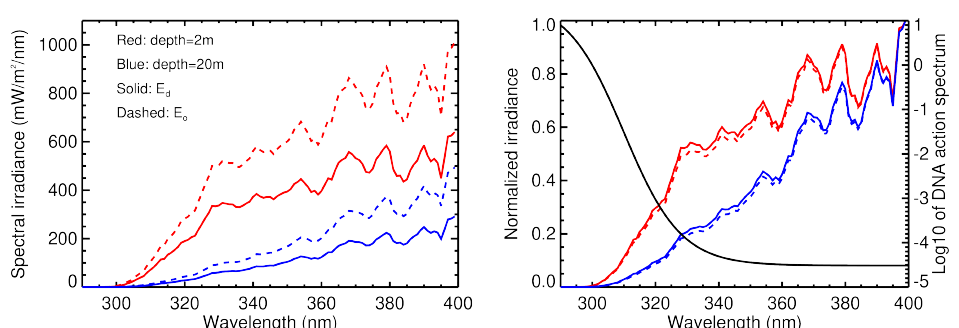
Figure 3. Spectral planar (solid lines) and scalar (dashed lines) irradiances. Left : Absolute values of the irradiances at two depths: 2m (red lines) and 20m (blue lines). Right : Planar and scalar irradiances normalized over their values at 400nm. The black line shows the DNA damage ac- tion spectrum.